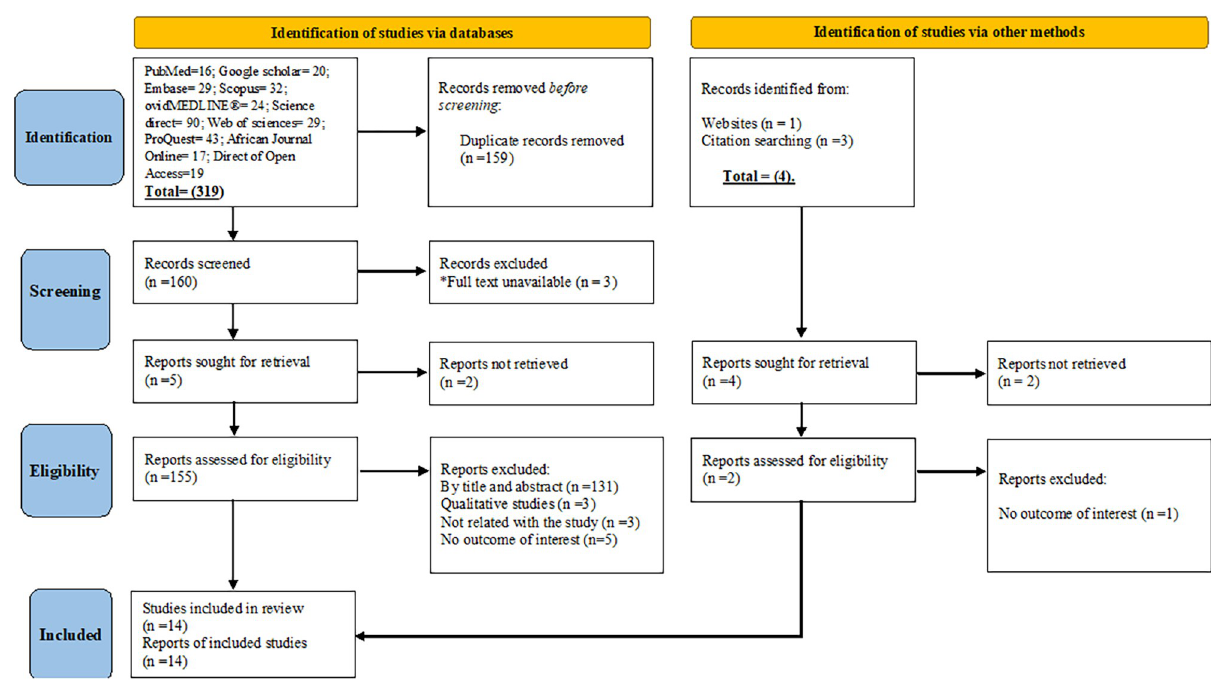
Fig 1. PRISMA flowchart for the selection of eligible studies on food handling practice among food handlers in foodservice establishments of Ethiopia, 2022.